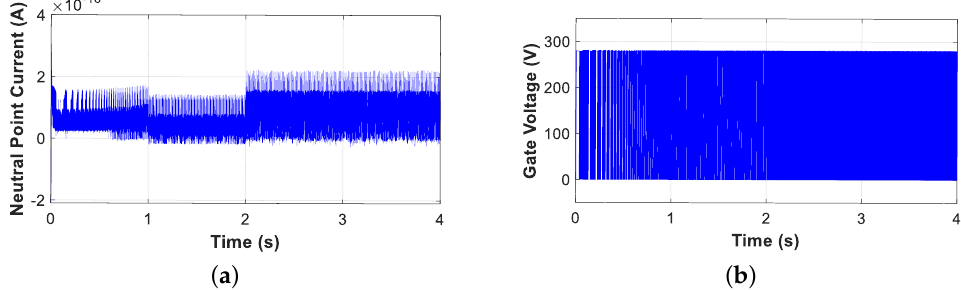
Figure 11. Current in the neutral point connection ( a ) and voltage over an inverter gate ( b ) during the speed command of 2000 rpm and load-torque disturbance.